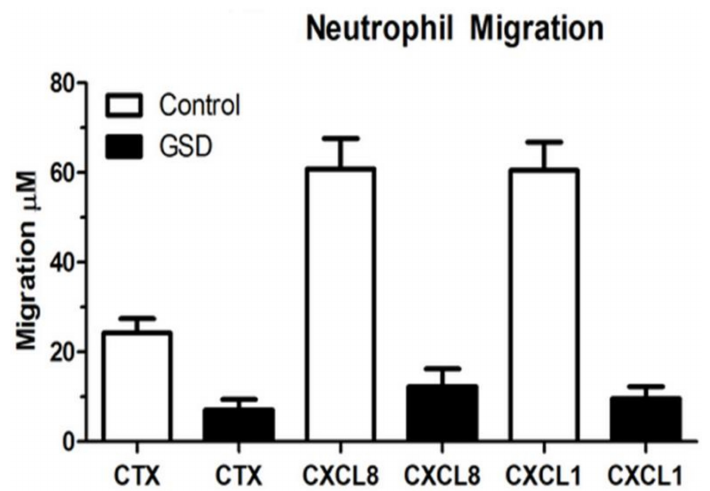
Figure 4. Impaired neutrophil chemotaxis in GSD Ib. Decreased peripheral neutrophil response to the chemokines CXCL8 (IL-8) and CXCL1.